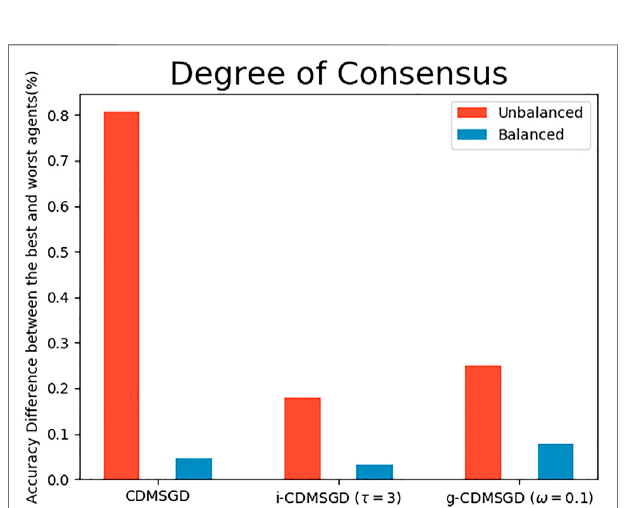
FIGURE 4 | The accuracy percentage difference between the best and the worst agents for different algorithms with unbalanced and balanced sample distribution among agents.